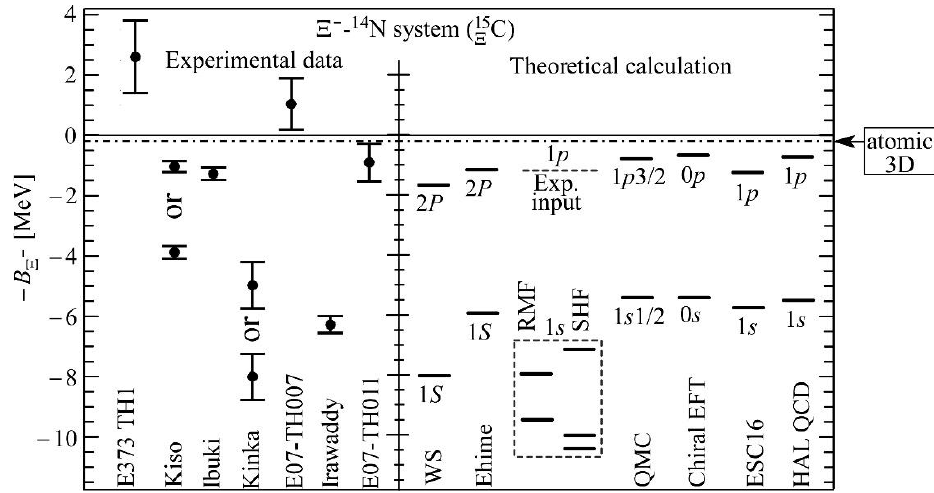
Fig. 2. Experimental data of B (cid:3) – and various theoretical calculations. Relevant references of both ones are given in Ref. [11] except for Chiral-EFT [19], ESC16 [20] and HAL-QCD